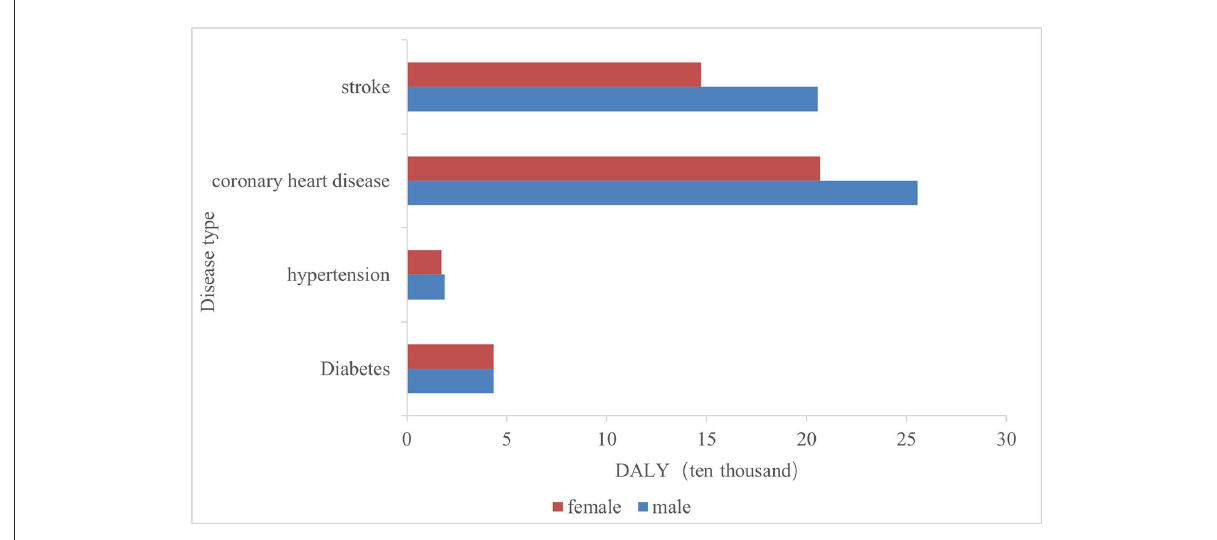
FIGURE1 Distribution of the DALY by sex for major chronic diseases.